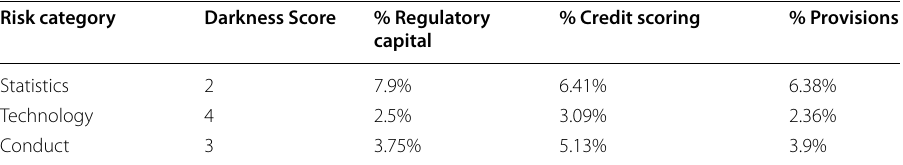
Table 4 Example scorecard of a model risk